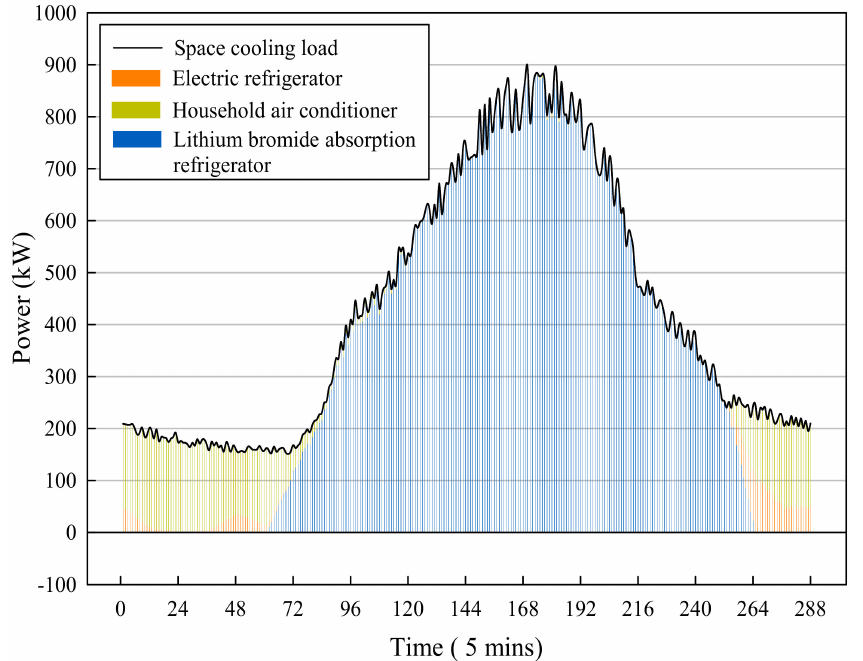
Figure 11. Real-time balance curve of space cooling